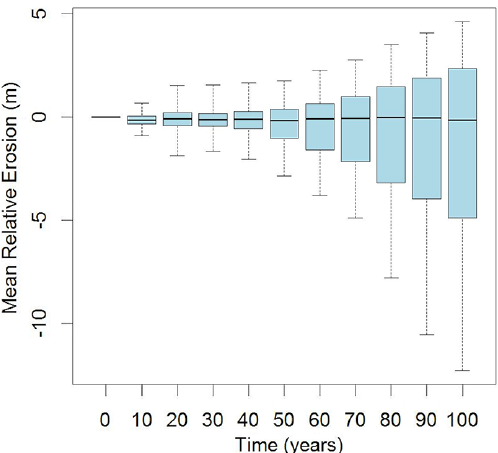
Figure 9. Box-and-whisker plot showing the evolution of spatially averaged mean relative coastal erosion, in comparison to the base- line, through time. The central bars represent the median value, the blue boxes show the interquartile range and the extended bars rep- resent extreme